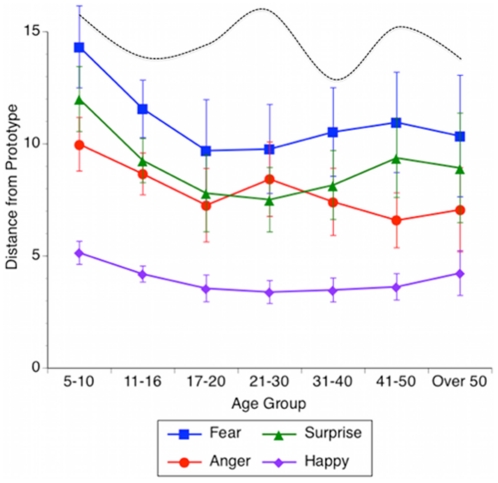
Emotional Experience Effects are Consistent Across Age Groups.Absolute value of the distance from the prototypical expression for all emotions across age groups. Data show mean and 95% confidence intervals. Dashed line indicates the distance from the prototypical expression of fear from those who report having experienced ‘Very Weak’ fear in their lives.